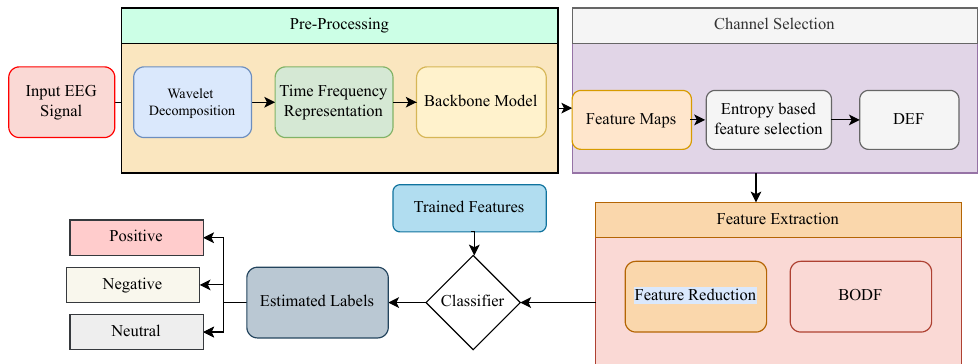
Figure 2. The proposed framework for classification of Emotions form the EEG signals of the SEED